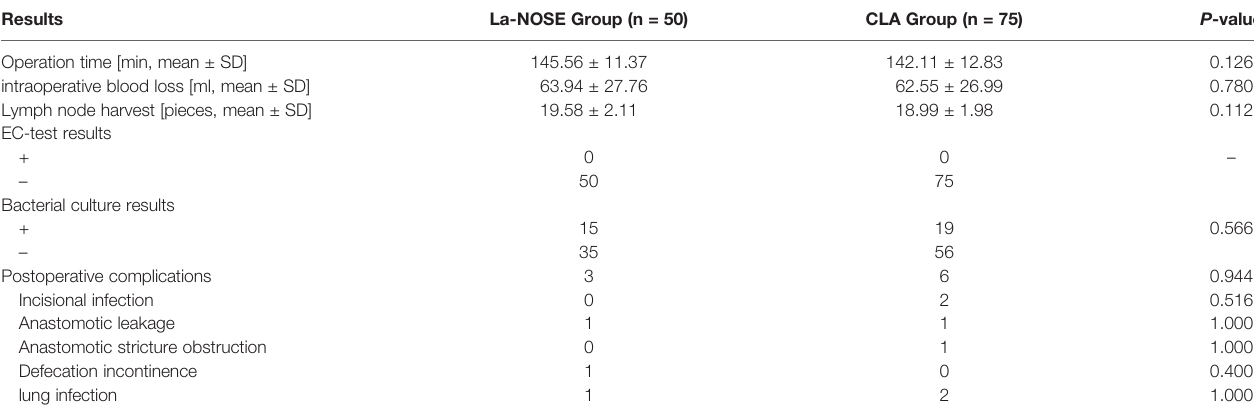
TABLE 2 | Intraoperative and postoperative results.